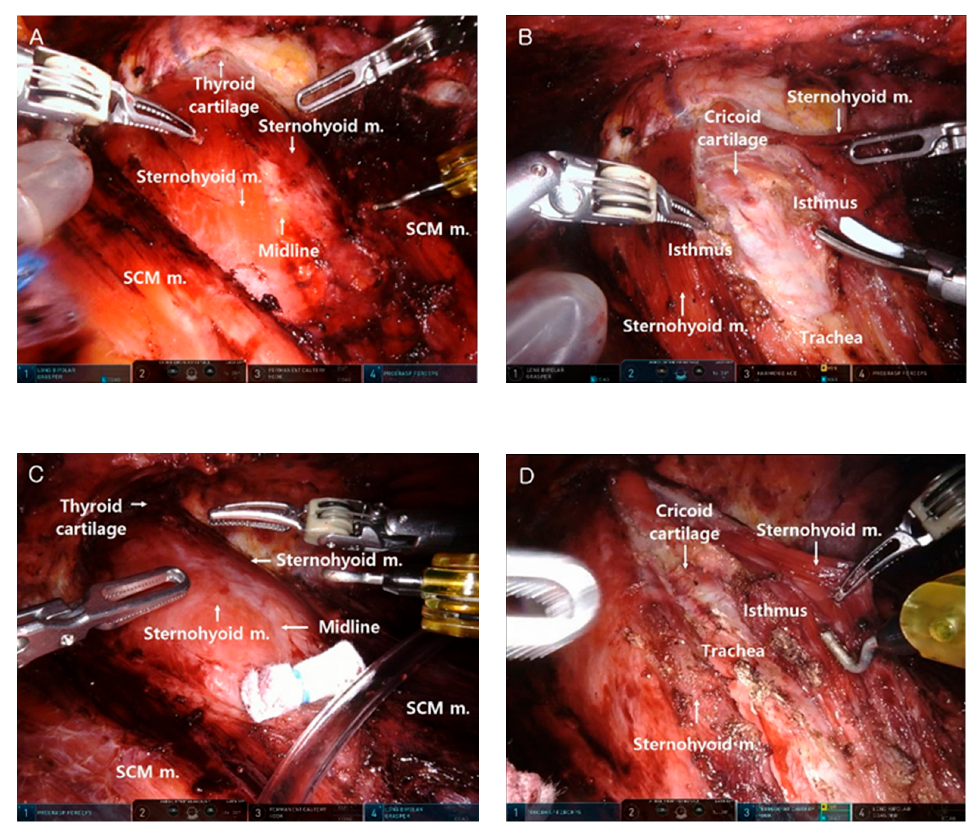
Figure 1. Comparison of surgical field between bilateral axillo-breast approach (BABA) robotic thyroid lobectomy and BABA robotic completion thyroidectomy. ( A ) Complete elevation of the skin flap at BABA robotic thyroid lobectomy. ( B ) Midline division and isthmectomy at BABA robotic thyroid lobectomy. ( C ) Complete elevation of the skin flap at BABA robotic completion thyroidectomy (BABA RCT). ( D ) Midline division and isthmus identification at BABA RCT. SCM: sternocleidomastoid muscle; Sternohyoid m.: sternohyoid muscle.